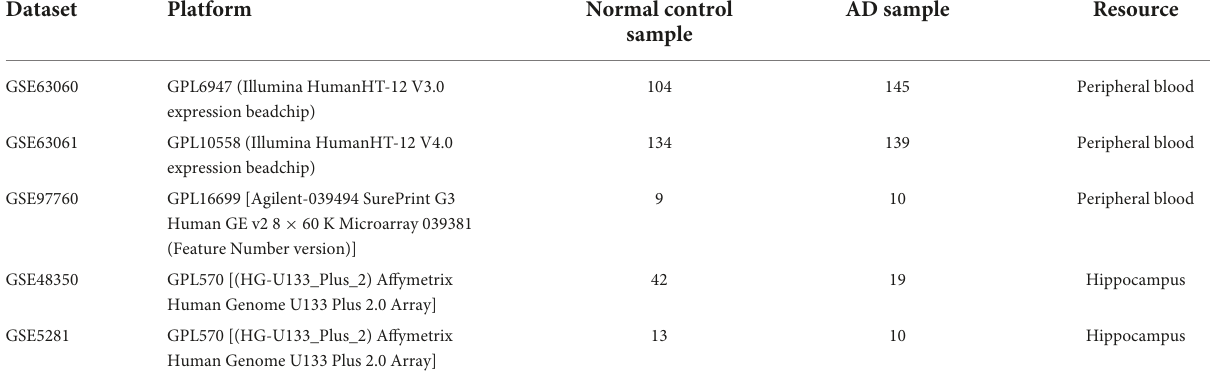
FIGURE1 The flow chart of this study.